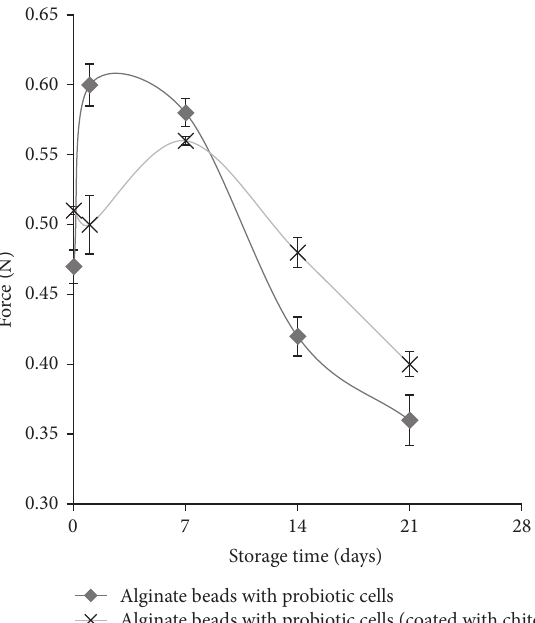
of the beads (alginate concentration 1.7%(w/v), means ± SD, 𝑛 = 30